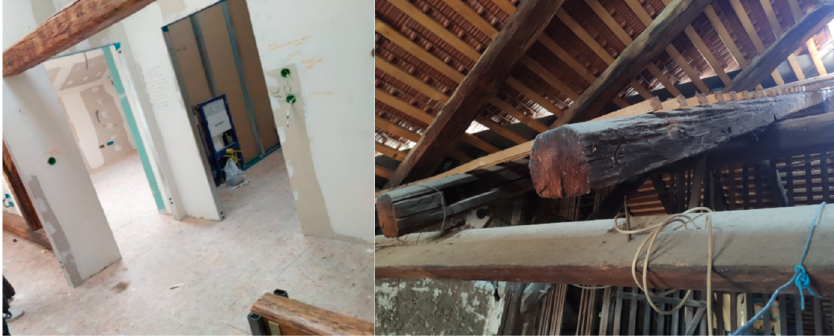
Figure 8. Damage to improper modification of the attic space or improper construction of the roof structure itself. (Photo credit: HCPI and Mislav Stepinac).